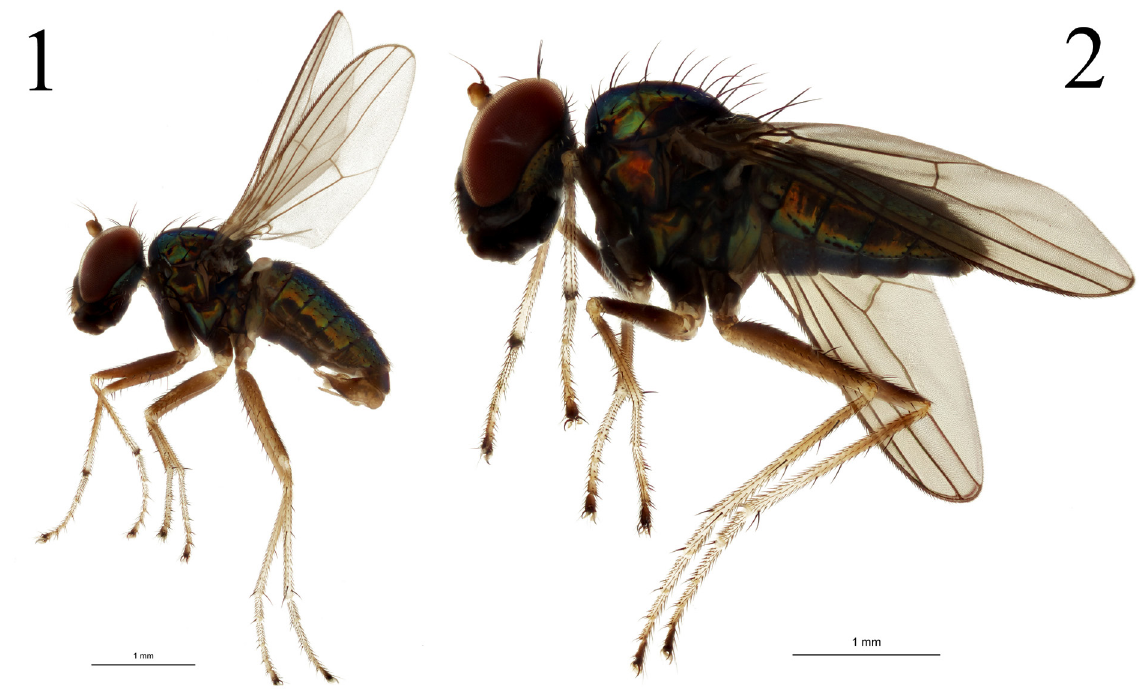
Figs 1–2. Thinophilus boonrotpongi sp. nov. 1 . ♂, habitus. 2 . ♀,